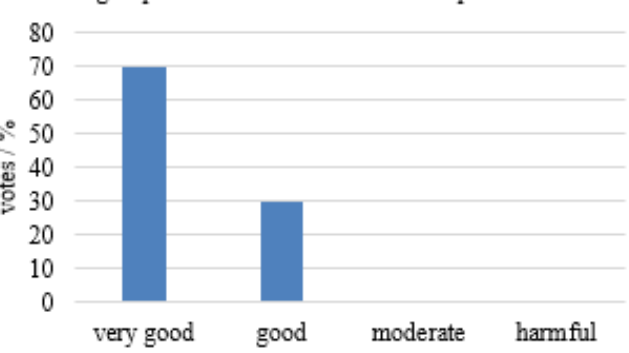
Fig. 9. Result of query in student-guided tutorial (single choice, N =